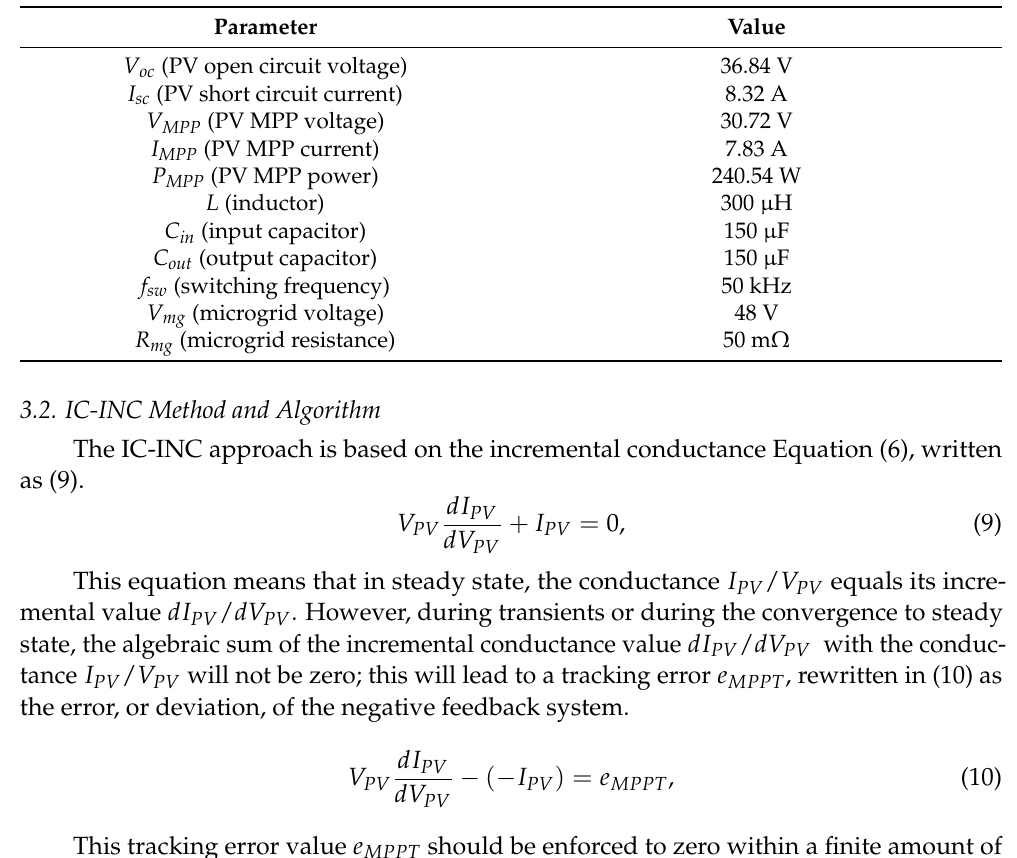
Table 2. Parameters of implemented